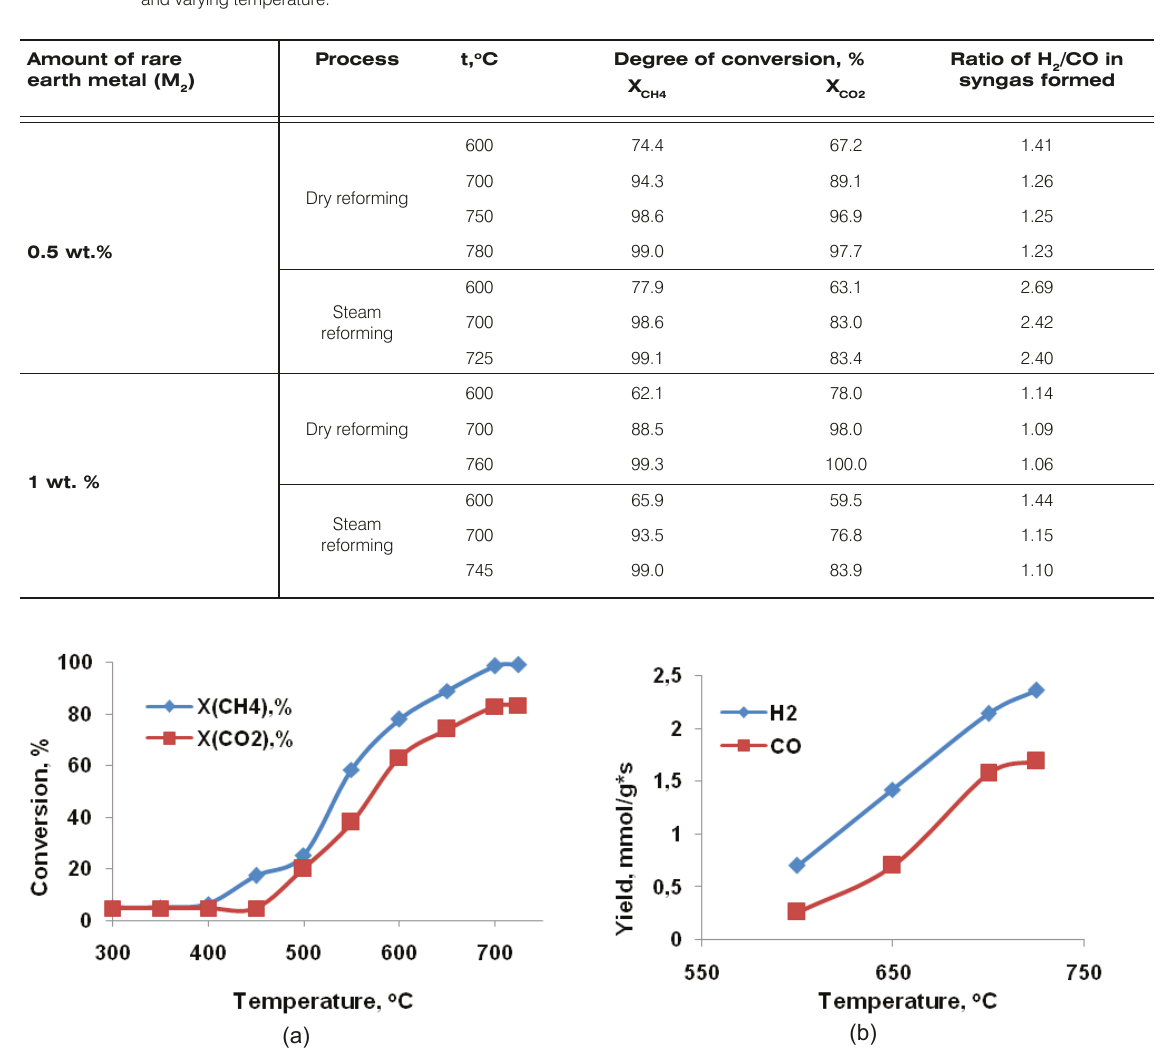
-M /Al O catalysts in the biogas reforming at C Н 1 2 2 3